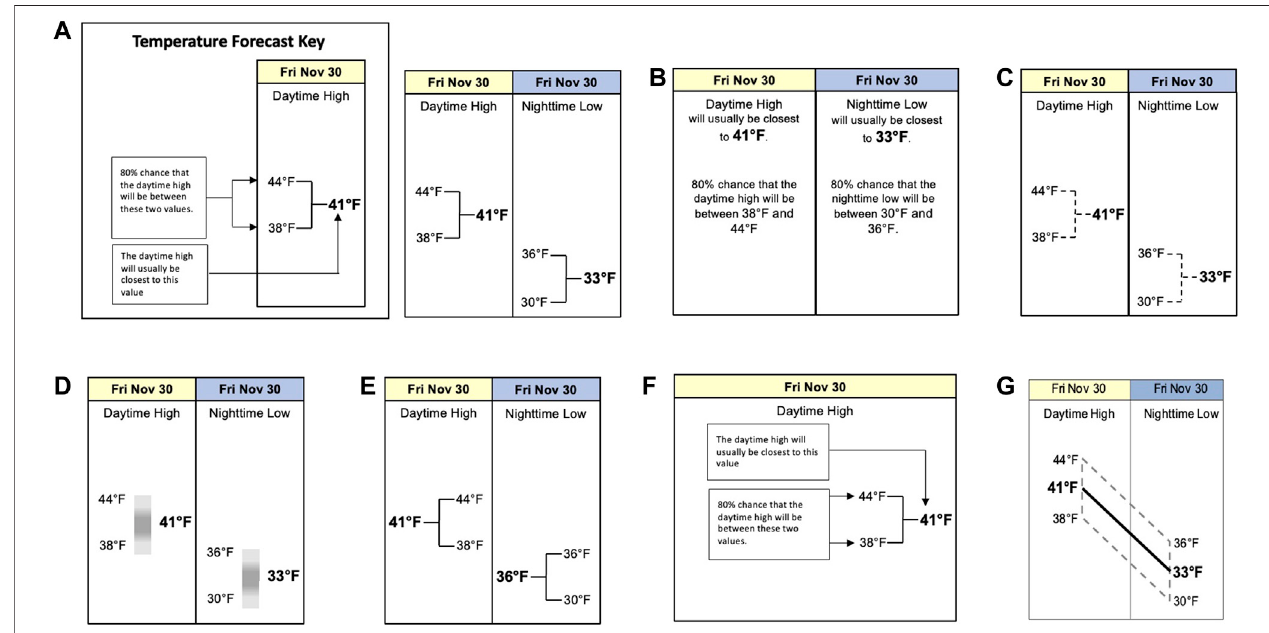
FIGURE 1 | Predictive intervals, each accompanied by a key (shown in a) describing “ 41 ° F ” as the “ best forecast ” . Note: Font and fi gure sizes are slightly smaller than they were in the original experiments to conform to journal requirements.